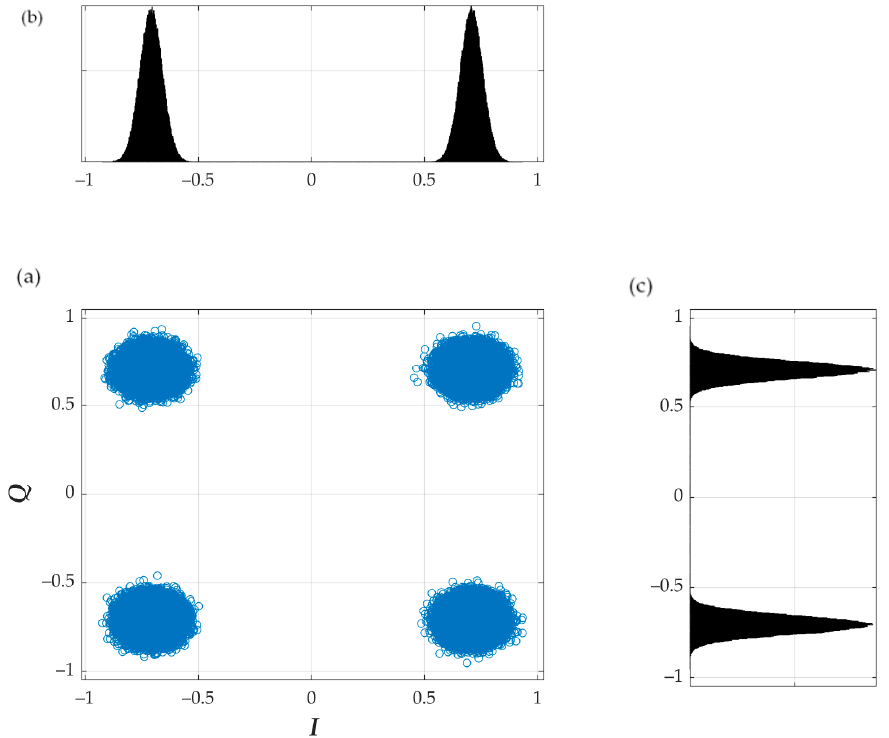
Figure 11. ( a ) Constellation, ( b ) in-phase and ( c ) quadrature histograms for 4 QAM cover and E b ⁄ N 0 = 20 dB, and without DCM covert channel.